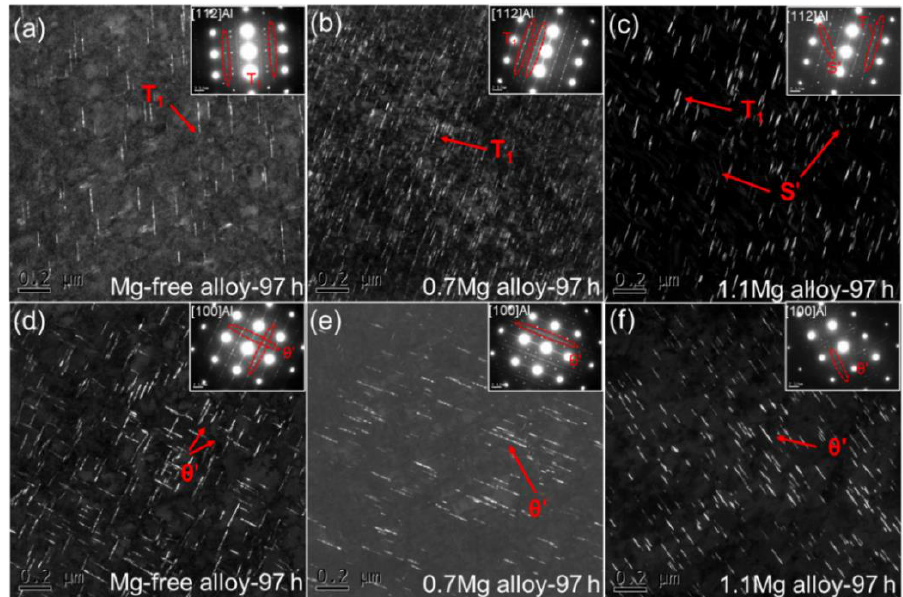
Figure 7. DF TEM images and corresponding SAED patterns for Al – Cu – Li alloys with different Mg content (Mg-free alloy ( a , d ), 0.7Mg alloy ( b , e ), 1.1Mg alloy ( c , f )) aged at 150 °C for 97 h. BF TEM images of Al – Cu – Li alloys with different Mg content aged at 150 °C for 37 h and 97 h are shown in Figure 8. Fine and continuous phases emerge at the high-angle grain boundary of the Mg-free alloy after being aged for 37 h (Figure 8a). The phases near the grain boundaries of the Mg-free alloy tend to disappear as the aging time increased to 97 h, while the intragranular phases appear (Figure 8d). The precipitates at the grain boundaries of the 0.7Mg alloy aged at 150 °C for 37 h (Figure 8b) are coarser than those of the Mg-free alloy, and the precipitates start to become discontinuous at grain boundaries. The precipitates at the grain boundaries become coarser and more discontinuous after